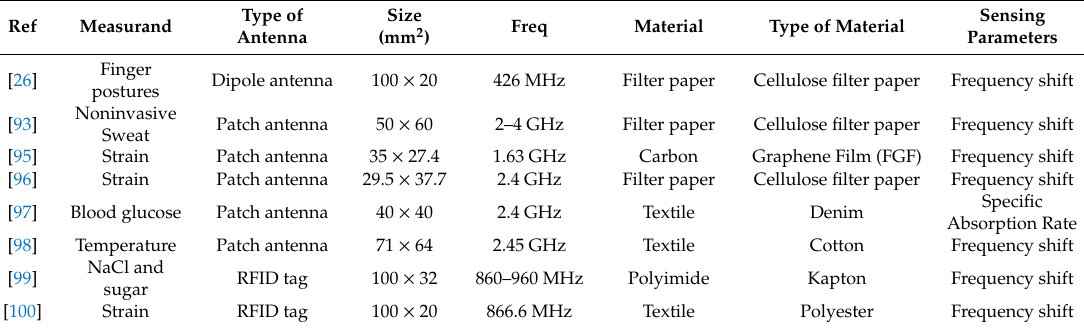
Table 6. List of some previously reported work of flexible textile antenna